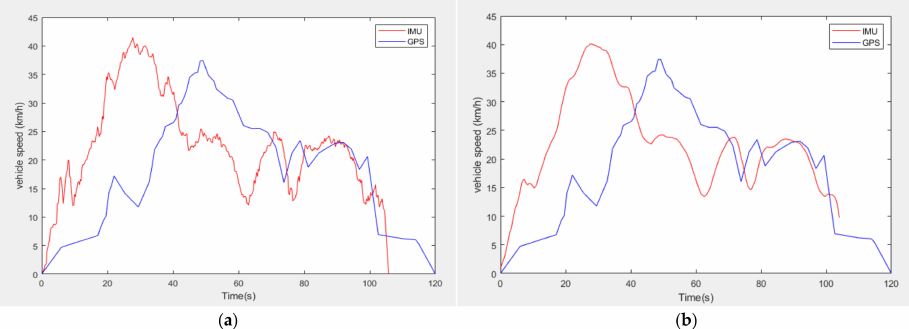
Figure 1. Comparison of IMU and GPS data for estimation of vehicle speed (km/h). ( a ) Without filtering ( b ) with filtering.